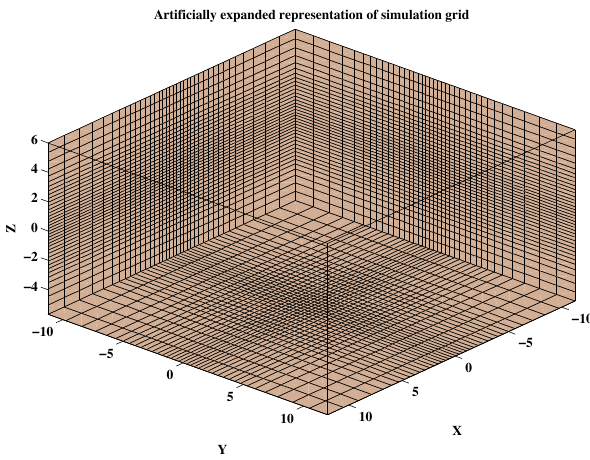
Fig. 1. Illustration of the numerical grid. Note that only every fourth grid point is plotted in order to improve visual